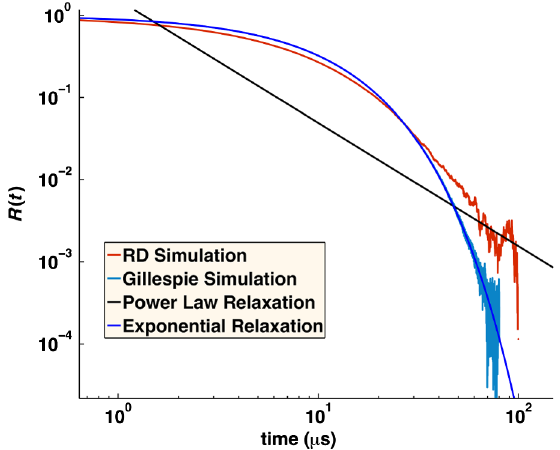
FIG. 12. Reversible reactions with k a ¼ 200 nm 3 = μ s and k b ¼ 10 6 s − 1 and A and B at equal concentrations ( 52 μ M) with equal